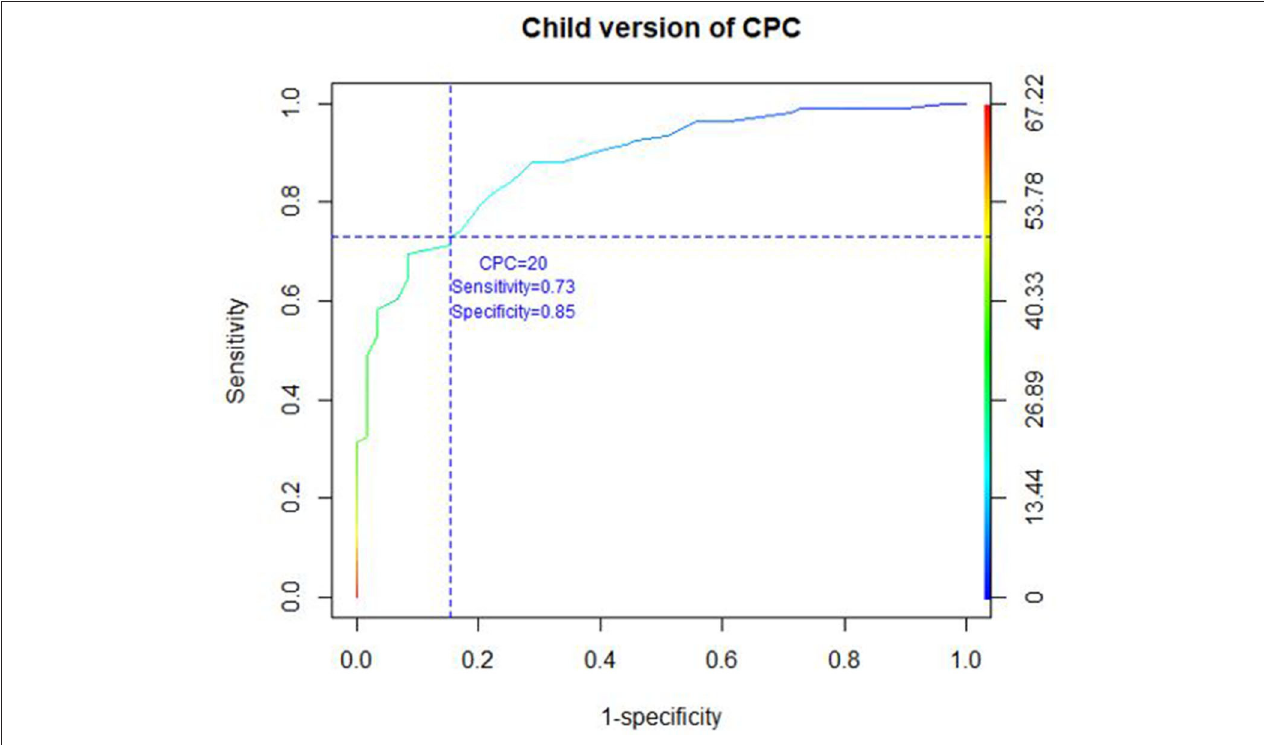
FIGURE 1 | ROC CURVE child version of